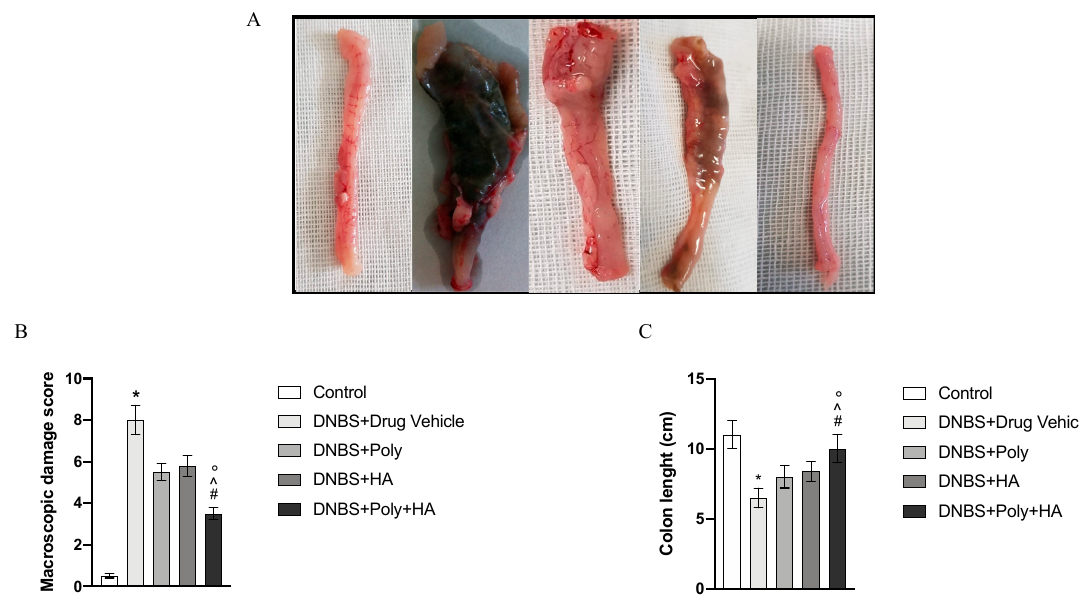
Figure 2. Macroscopic appearance of colon tissues ( A ) from Control (1), DNBS + Drug vehicle (2), DNBS + Poly (3), DNBS + HA (4), DNBS + Poly + HA (5). The graphs represent macroscopic damage scores ( B ) and colon length ( C ). Values were obtained from 10 animals per group and are expressed as the means and SD. * p < 0.0001 vs. control group; # p < 0.0001 vs. DNBS + Drug vehicle group; ◦ p < 0.001 vs. DNBS + HA; ˆ p < 0.001 vs. DNBS + Poly.